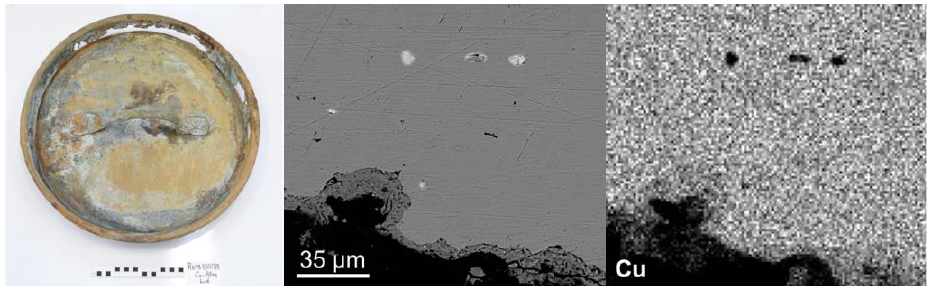
Figure 6. SEM image (BSE detector) and elemental map of copper (Cu) of a cross-section from a sample collected from the rim of a copper lid (on the left).